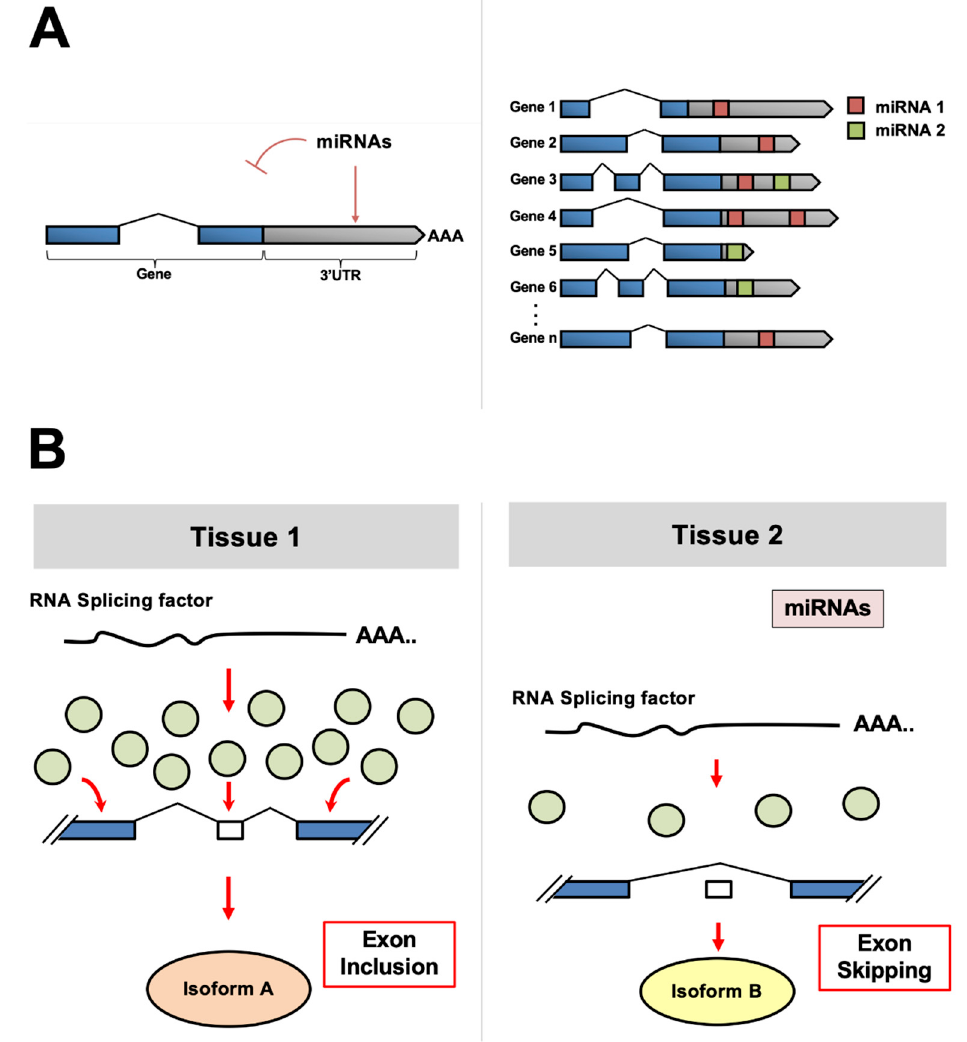
Figure 1. ( A ) miRNAs bind to target genes within their 3 ′ UTR and repress their translation ( Left ). Since the pairing between the miRNAs and its target sequence is not perfectly complementary, a single miRNA may target and repress multiple mRNA transcripts ( Right ). ( B ) As shown in Tissue A and Tissue B, miRNAs may differentially regulate the abundance of RNA splicing factor proteins (shown as light green circles). Tissue 1 ( Left ) has a higher dosage of the RNA splicing factor due to a lack of miRNAs available to inhibit their translation. In this specific example, the abundance of splicing factors leads to an intron inclusion event (Isoform A). In contrast, in Tissue 2 ( Right ), miRNAs that target the RNA splicing factor lower its abundance, interfering with the splicing pattern of target genes. In this specific example, this leads to an intron exclusion event (Isoform B).